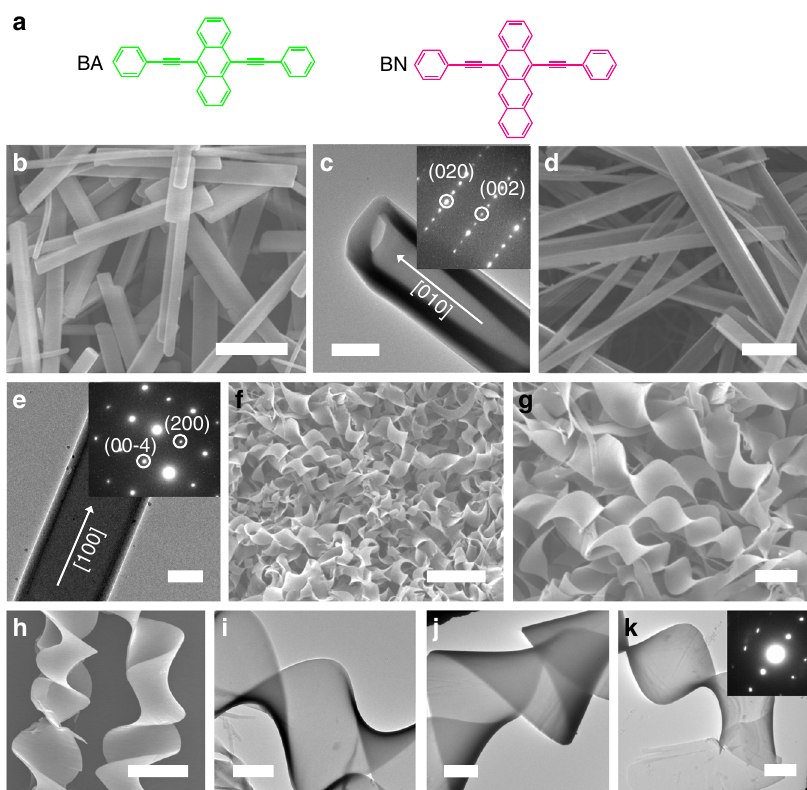
Fig. 1 Molecular design and morphology characterization of BA, BN, and BA/BN helical assemblies. a Schematic showing the molecular structures of BA (green) and BN (pink). b , d , f , and g SEM images of ( b ) BA tubes, ( d ) BN tubes, and BA/BN helical ribbons obtained at m/m = 2:1 and v/v = 4:1 at ( f ) low and ( g ) high magni fi cation. Scale bars, 10 μ m in b , d , g and 30 μ m in f . TEM images of single c BA and e BN tubes. Scale bars, 2 μ m in c and 200 nm in e . Insets show the selected-area electron diffraction (SAED) patterns of BA and BN tubes, respectively. h SEM and i , j TEM images of single ( i ) left- and ( j ) right-handed helical ribbons. Scale bars, 10 μ m in h and 30 μ m in i , j . k TEM image of single typical helix. Inset shows the corresponding SAED